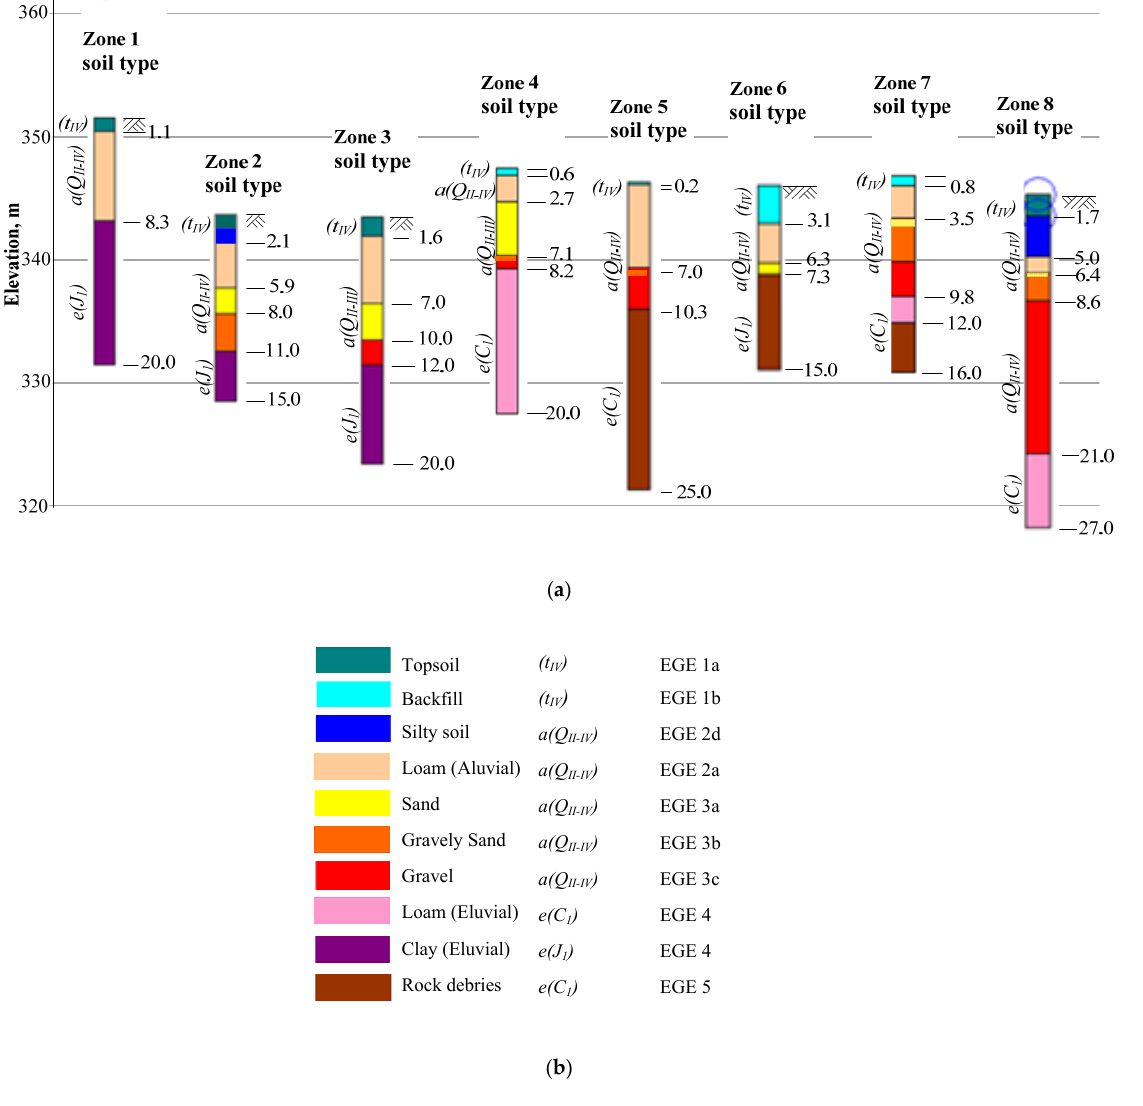
Figure 7. Zoning of the territory of Nur-Sultan city by types of the soil bases: ( a ) city map with differentiation by soil type zones, ( b ) vertical profiles of boreholes for each type of soil zones with decoding.